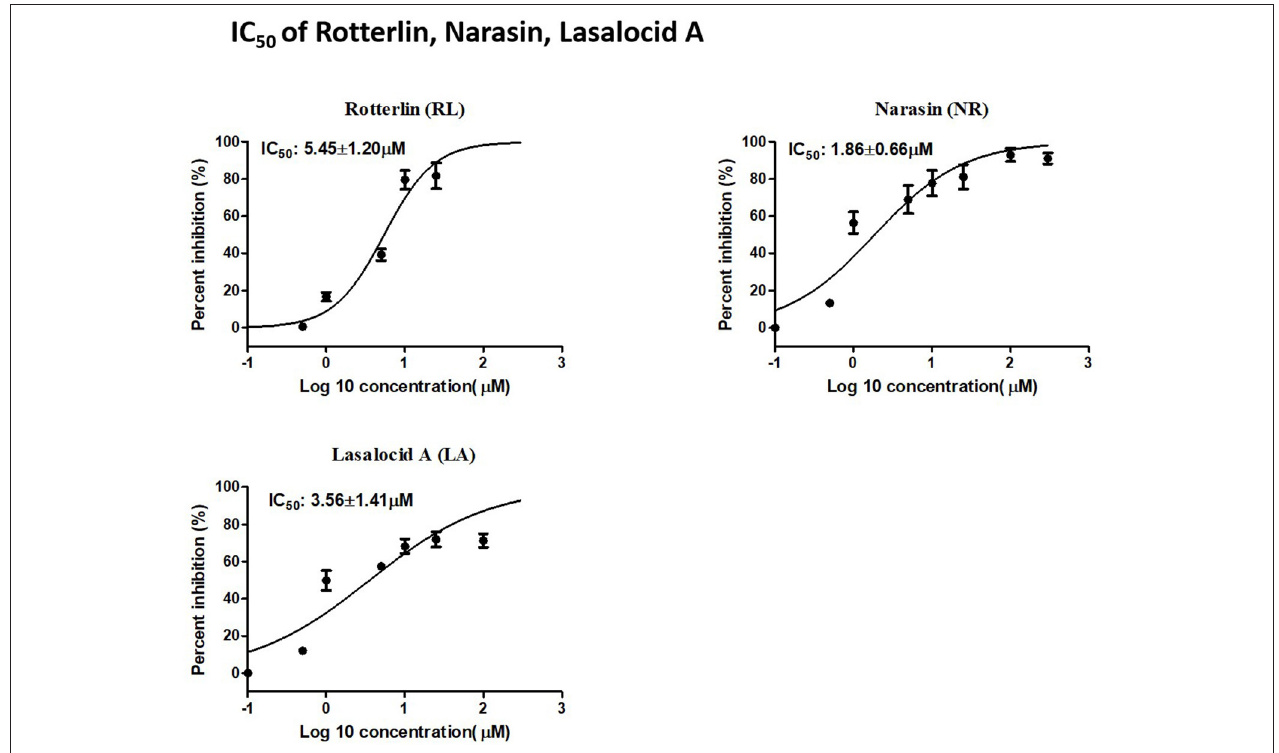
FIGURE 2 | IC50 of Rotterlin, Narasin, Lasalocid